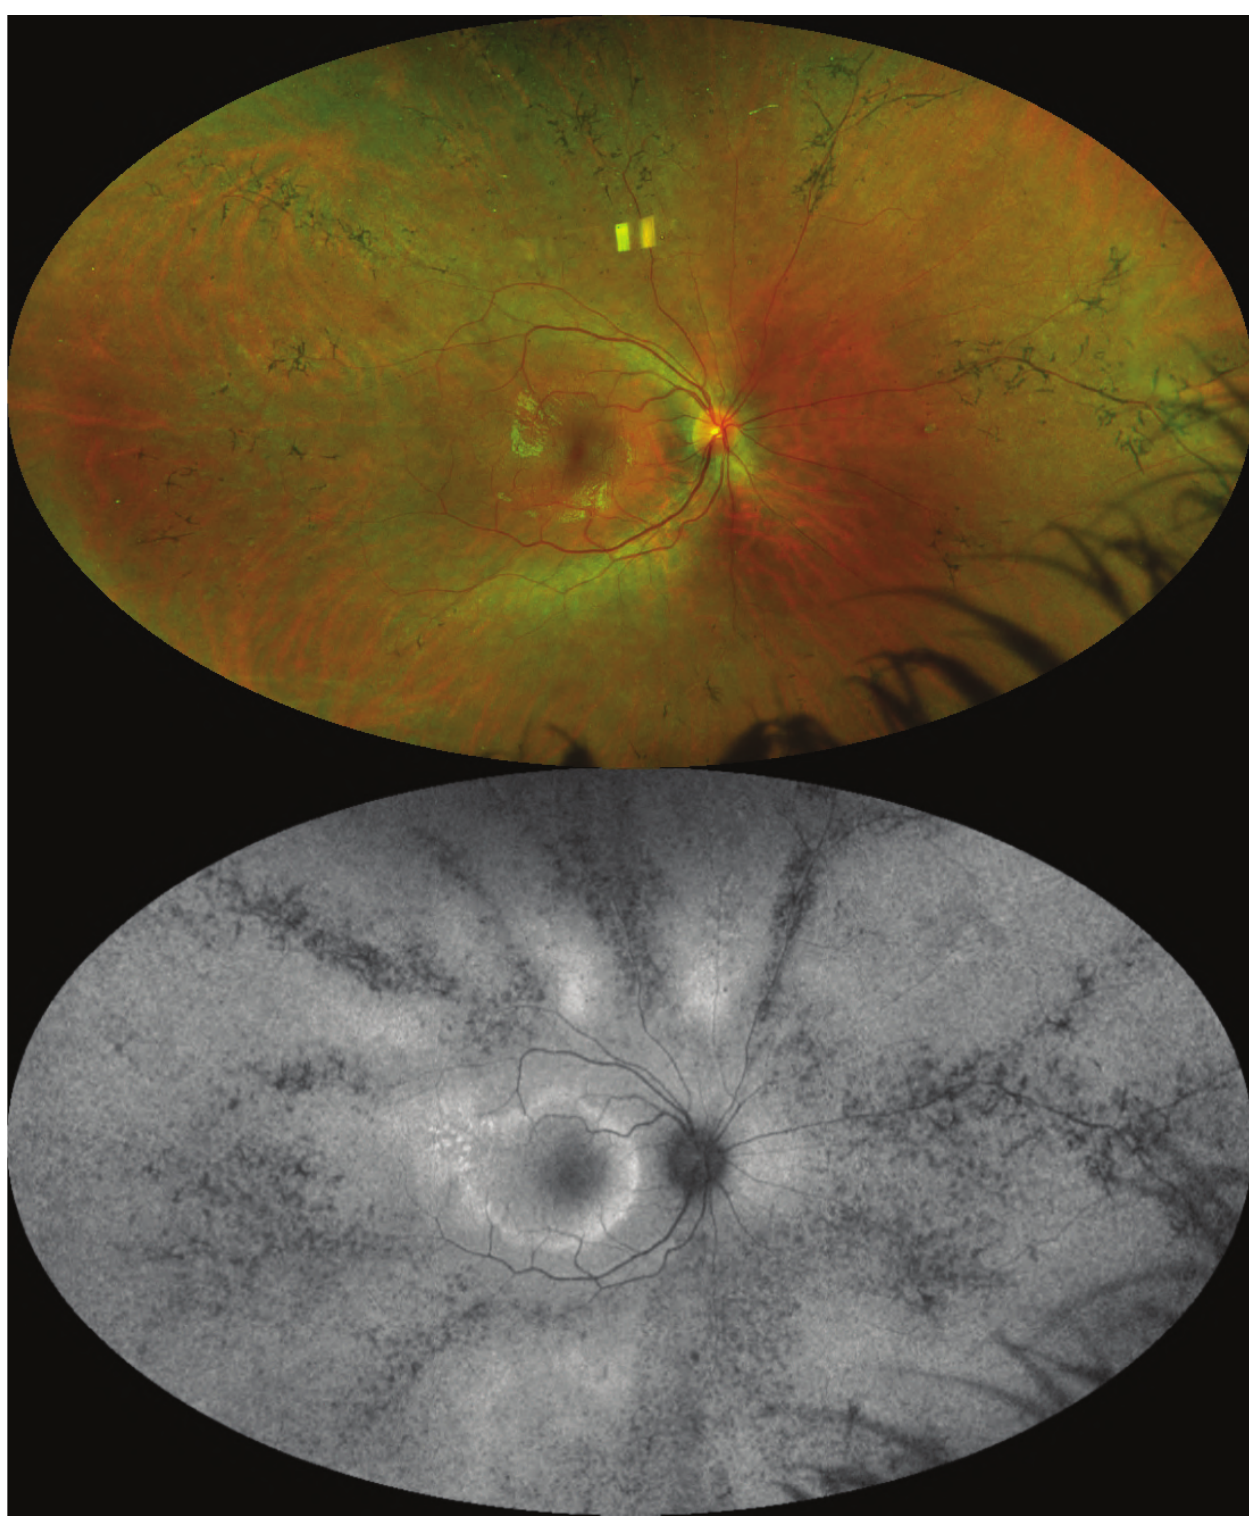
Figure 8. Fundus imaging of a patient with pigmented perivenous retinochoroidal atrophy (PPRCA). Top: Pseudocolor ultrawide field (UWF) imaging of the right eye (Optos). Note the bone spicule pigment clumping and chorioretinal atrophy around the retinal veins. Bottom: Green light UWF fundus autofluorescence imaging of same eye (Optos). Note more obvious hypoautofluorescent (hypo-AF) changes in the periphery than can be seen on the color imaging. A hyperautofluorescent (hyper-AF) macular ring can be